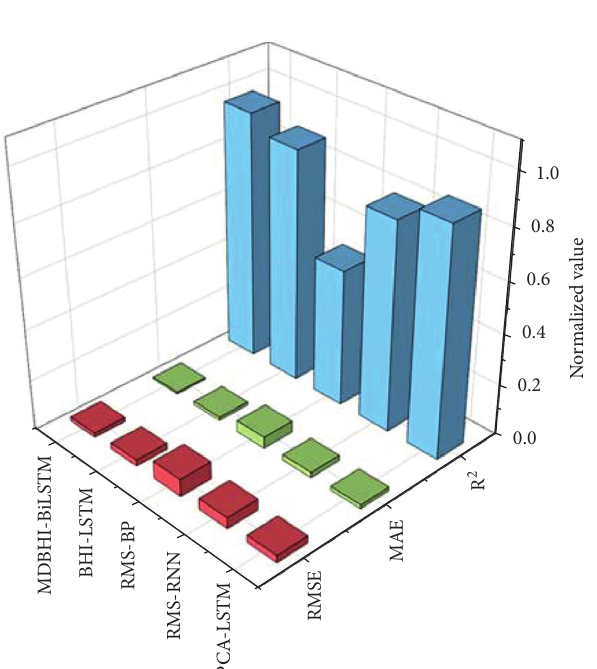
Figure 17: Comparison of five prediction performance